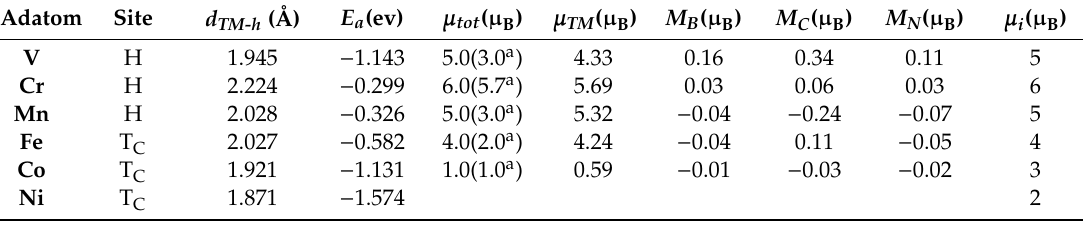
Table 2. The most stable position of each metal atom of the adsorption system, the adsorption energy ( E a ), the vertical height ( d TM-h ) between adsorption atoms and BC 2 N plane, the total magnetic moment ( µ tot ) of the adsorption system, magnetic moment of adsorption atom ( µ TM ), and atomic magnetic moment of B, C and N ( M i ), ( µ i ) is the magnetic moment of the free-standing states of transition metal